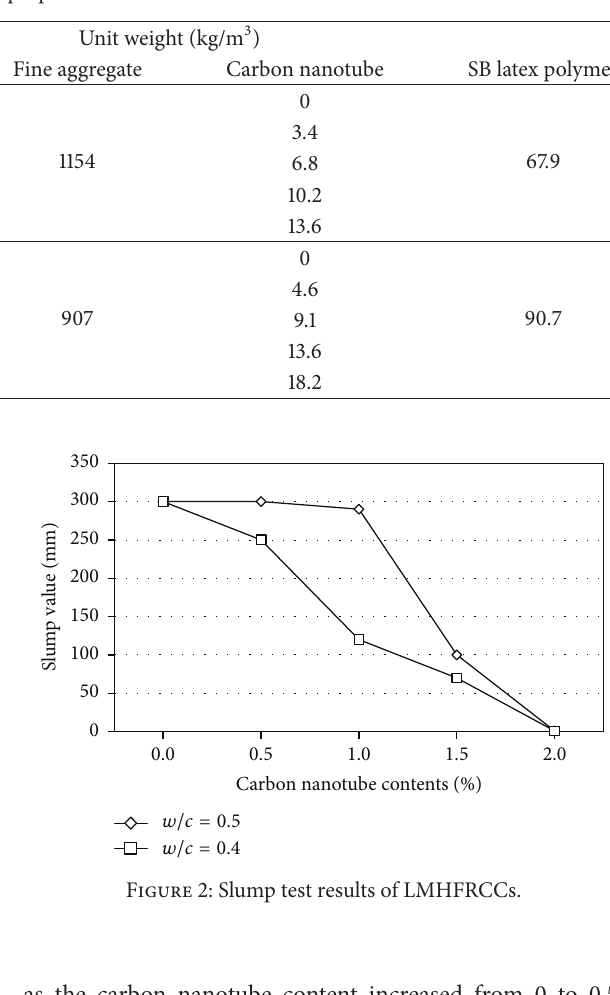
Table 6: Mix proportions.